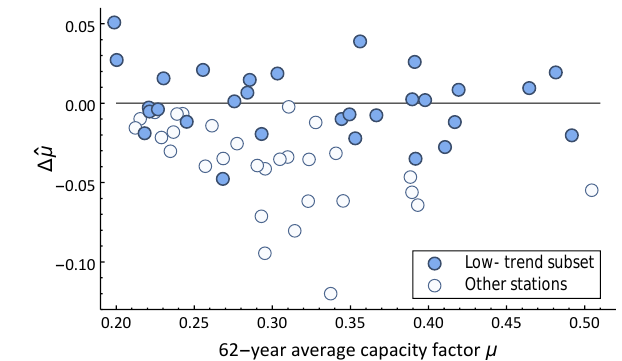
Figure 3. Difference (cid:49) ˆ µ between the final 20 years average ca- pacity factor and next-to-final 20 years average capacity factor vs. 62-year long-term average capacity factor µ for the 30 stations of the near-zero trend subset (filled) and for all the 60 considered sta- tions (filled +